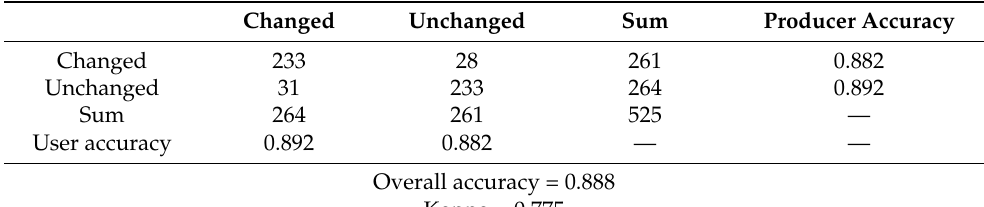
Table 5. Change detection accuracy of object-based Landsat imagery.